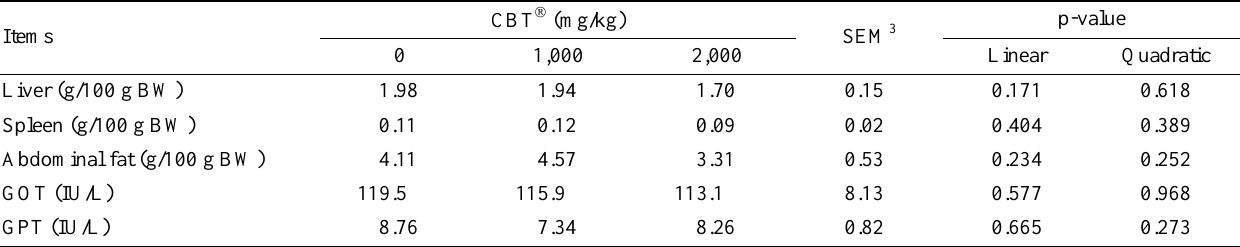
Table 4. Effects of dietary CBT  supplementation on relative weight of organs and blood parameters in laying hens 1,2